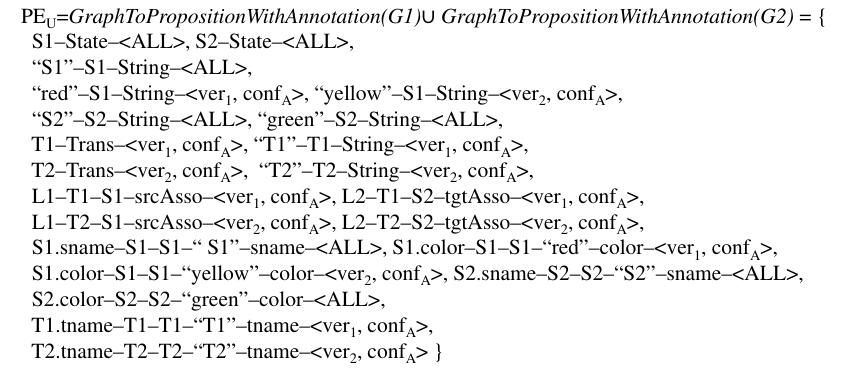
Figure 20. Union of the propositional encodings of M1 and M2.